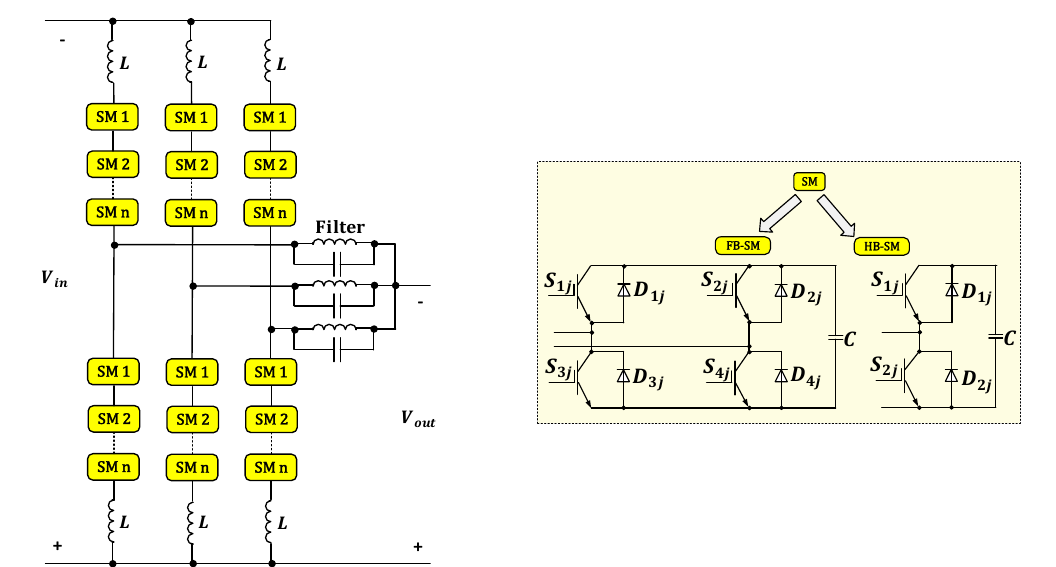
Figure 7. Modular Multilevel DC-DC converter (MMC) circuit diagram.